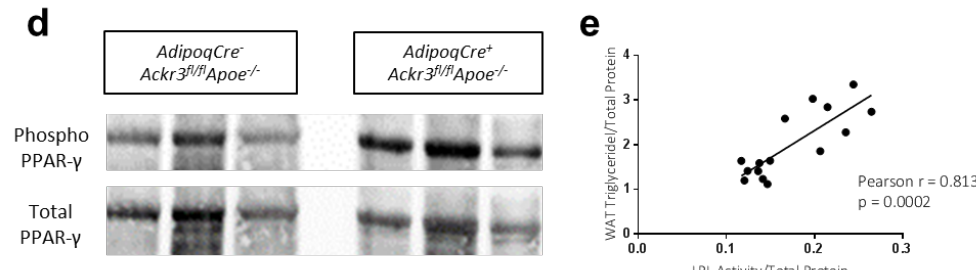
Figure 3. ACKR3 modulates lipid levels in wAT via ANGPTL4 and PPAR γ . ( a , b ). Relative gene expression of Angptl4 ( a ) and Pparg ( b ) to housekeeping genes ( Gapdh or 18S ) analyzed on ddPCR (all n = 4–7). ( c ). Quantification of the western blot phospho-PPAR- γ signal normalized to total PPAR- γ signal on Image-J Software ( n = 4). ( d ). Representative images of phospho-PPAR- γ and total PPAR- γ protein expression in wAT samples analyzed using western blot (Figure S2). ( e ). Pearson r correlation between wAT total triglyceride content and wAT LPL activity (r = 0.8137, p = 0.0002), ( n = 15). * p < 0.05, ** p < 0.01, *** p < 0.001.